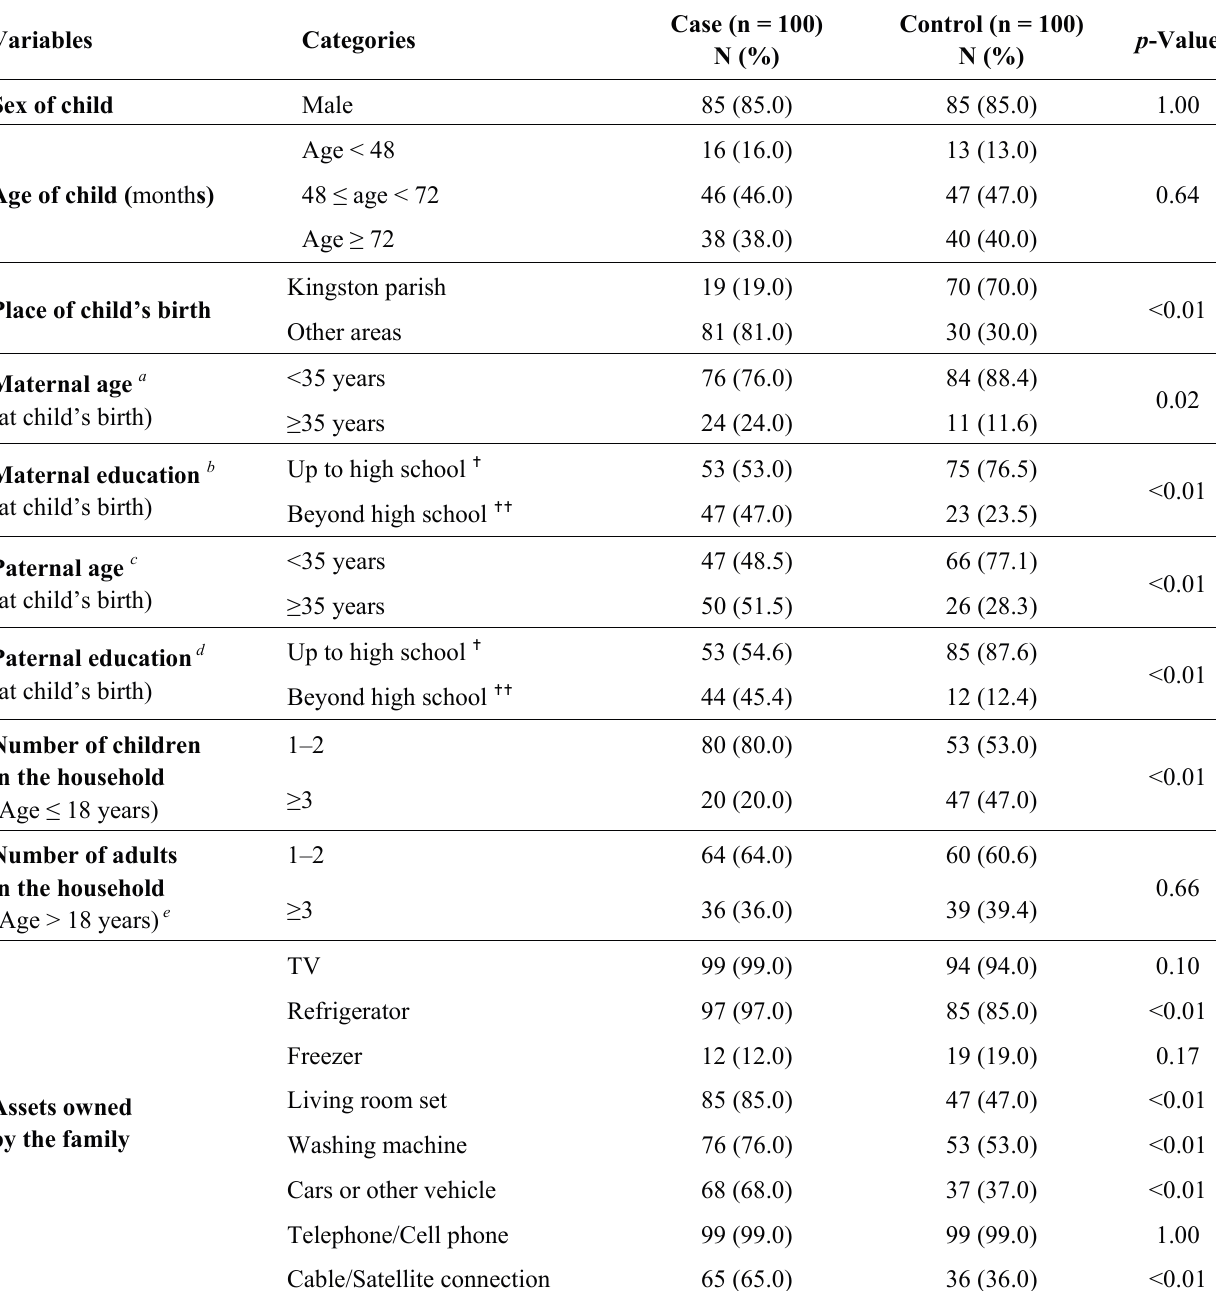
Table 1. Demographic and socioeconomic characteristics of children and their parents by ASD case status (200 children or 100 matched